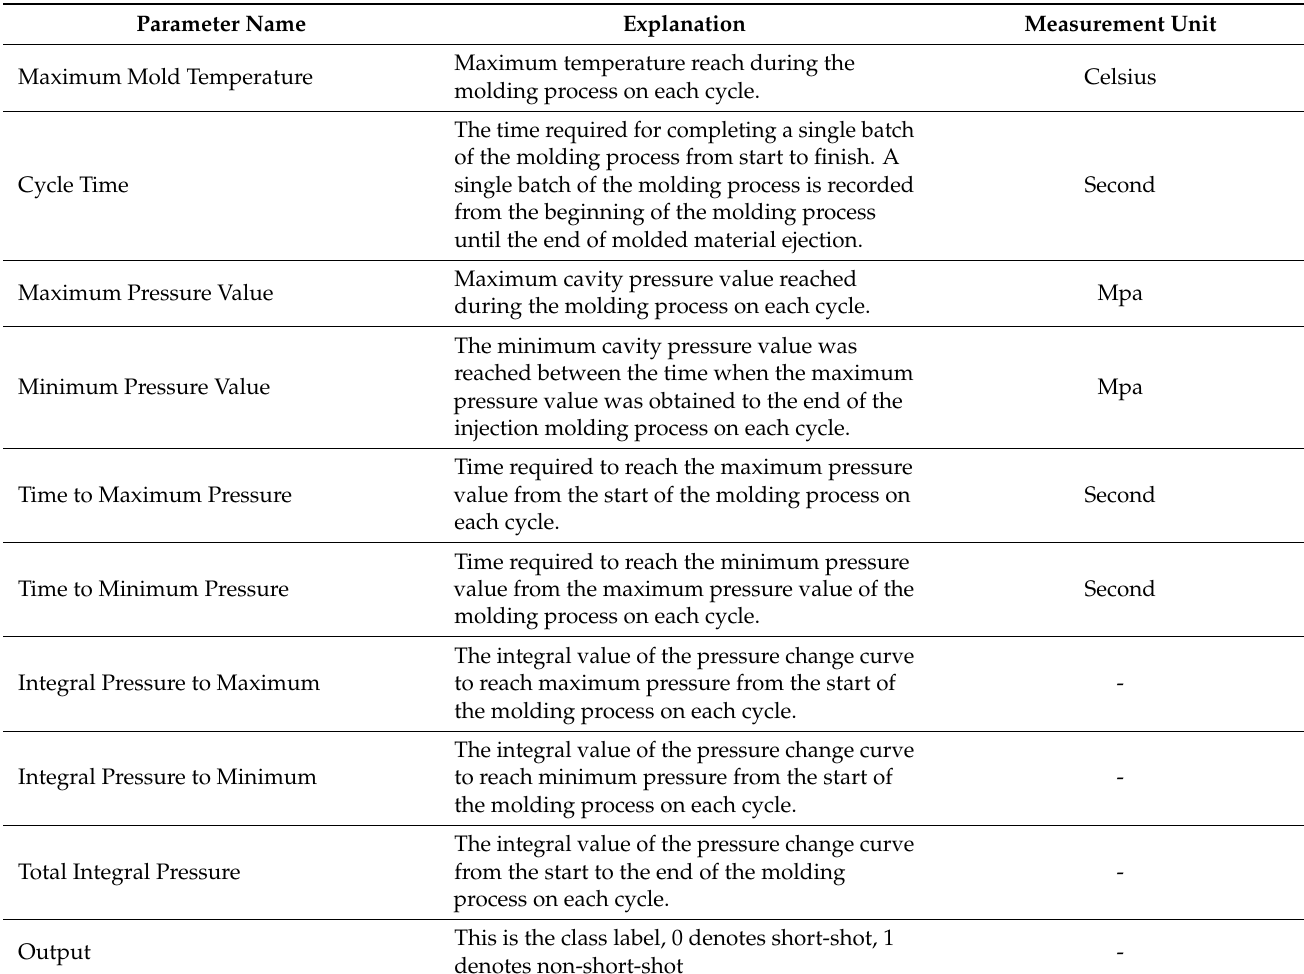
Table 1. The parameter of the injection molding process.